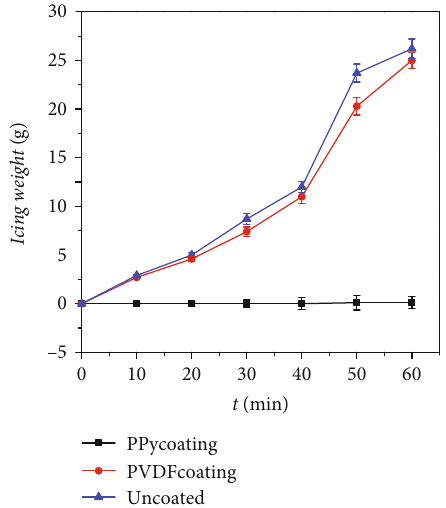
Figure 9: The comparison results of icing change on three blade